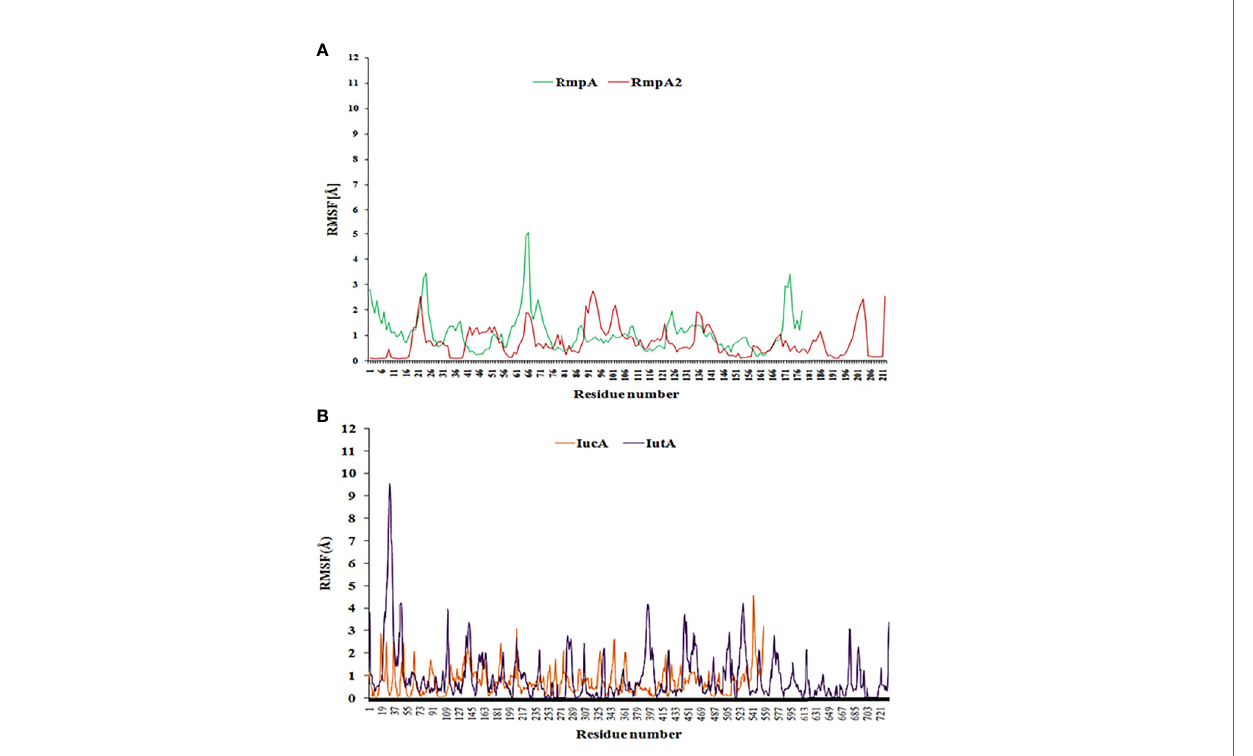
FIGURE 6 | The RMSF curve from coarse-dynamics simulations. Relative RMSF of (A) RmpA and RmpA2 (B) IucA and